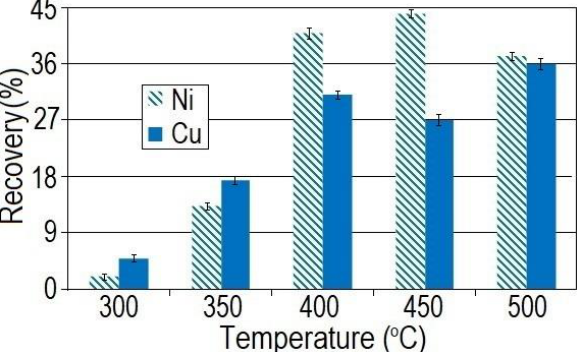
Figure 8. Recovery of metals into solution depending on the roasting temperature of a 1:2 mixture of concentrate and ammonium sulfate.